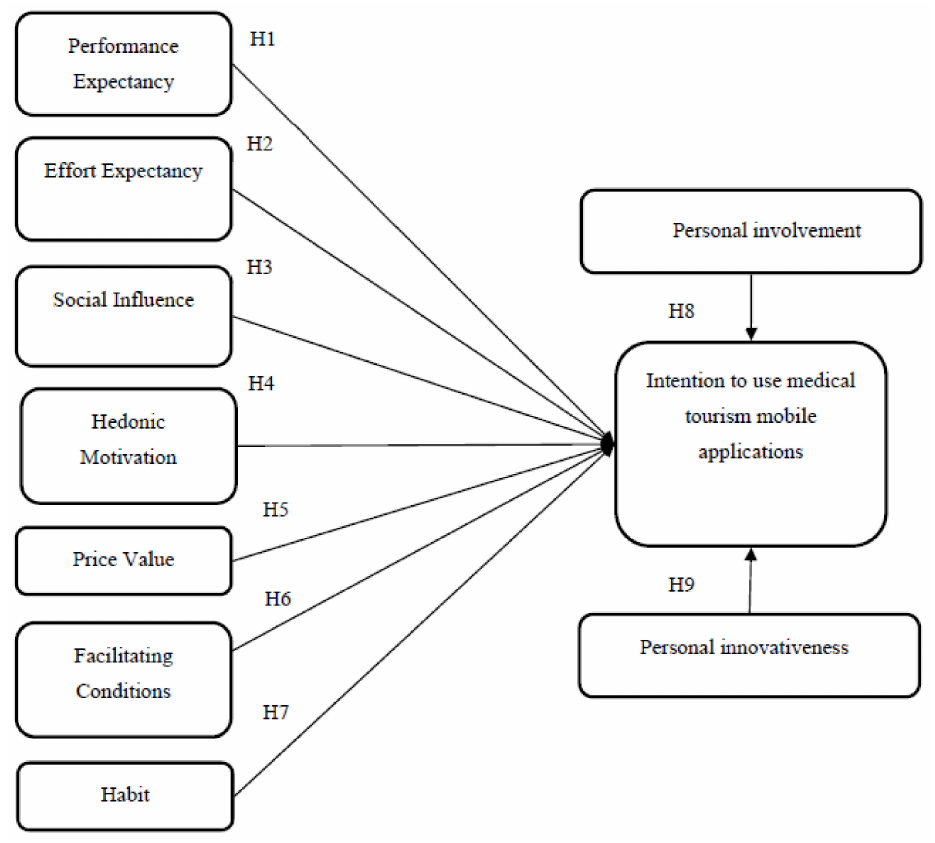
Figure 1. Research